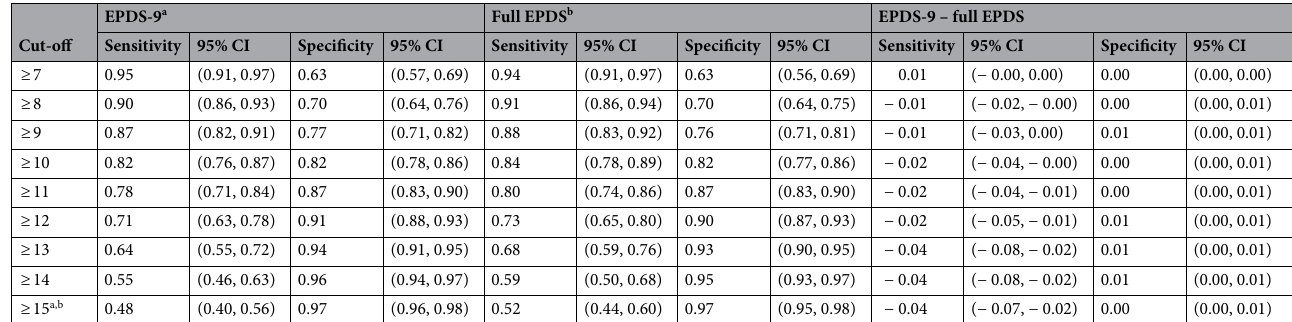
Table 3. Comparison of sensitivity and specificity estimates between EPDS-9 and full EPDS across cut- offs 7–15 for studies that used all reference standards (N Studies = 41; N Participants = 10,906; N major depression = 1407). CI, confidence interval; EPDS, Edinburgh Postnatal Depression Scale. a For EPDS-9 cut-off 15, among all studies, the default and bobyqa optimizers in glmer failed to converge, thus L-BFSG-B was used instead. b For full EPDS cut-off 15, among all studies, the default optimizer in glmer failed to converge, thus bobyqa was used